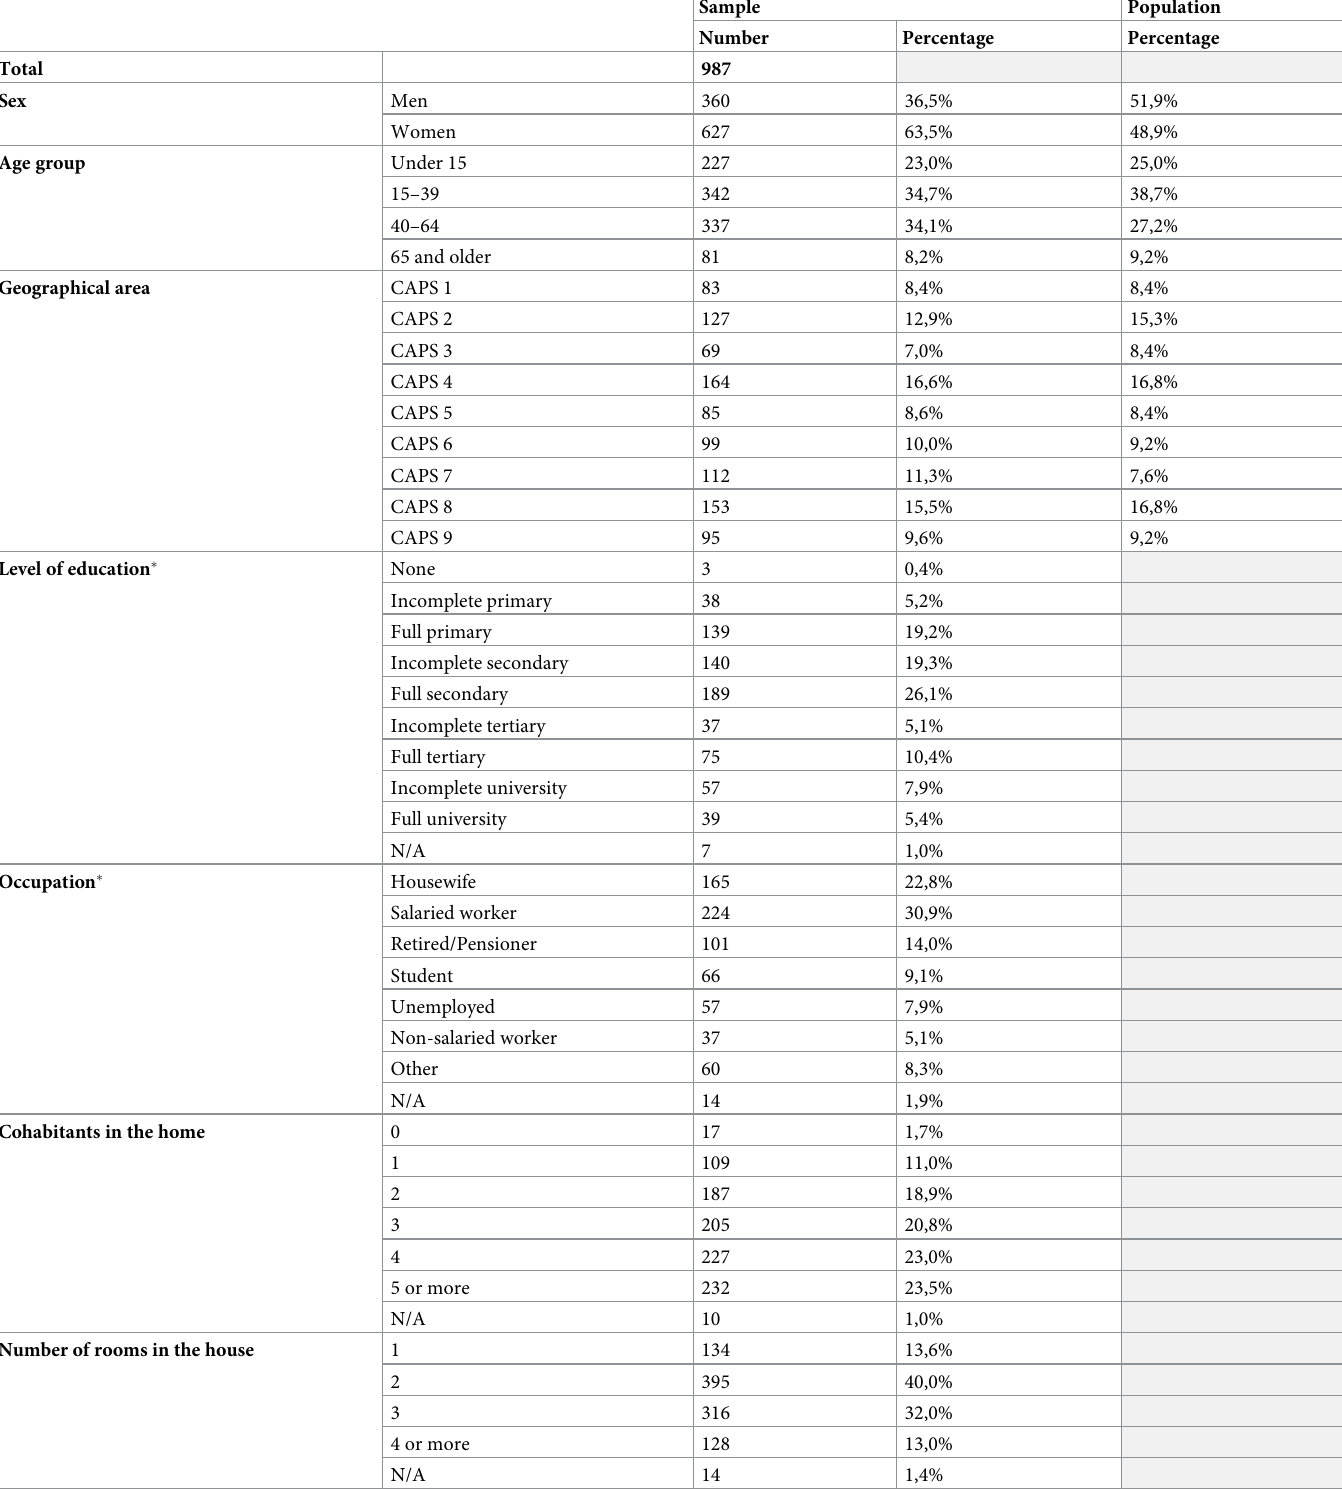
Table 1. Sociodemographic and clinical characteristics of the studied sample and relationship with the population estimates of Puerto